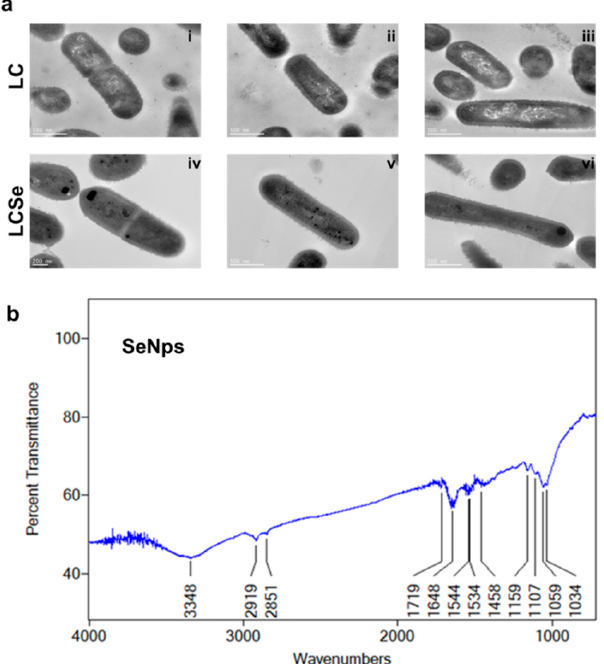
Figure 1. Characteristics of SeNps. ( a ) TEM images of L. casei ATCC 393 bacteria grown in their standard medium (LC) (i–iii) or in the presence of 20 µ g/mL NaHSeO 3 (LCSe) (iv–vi). Note the dark spots present only in LCSe, indicating the intracellular formation of SeNps (magnification: 10,000 × ). ( b ) µ -FTIR spectrum of biogenic SeNps synthesised by L. casei ATCC